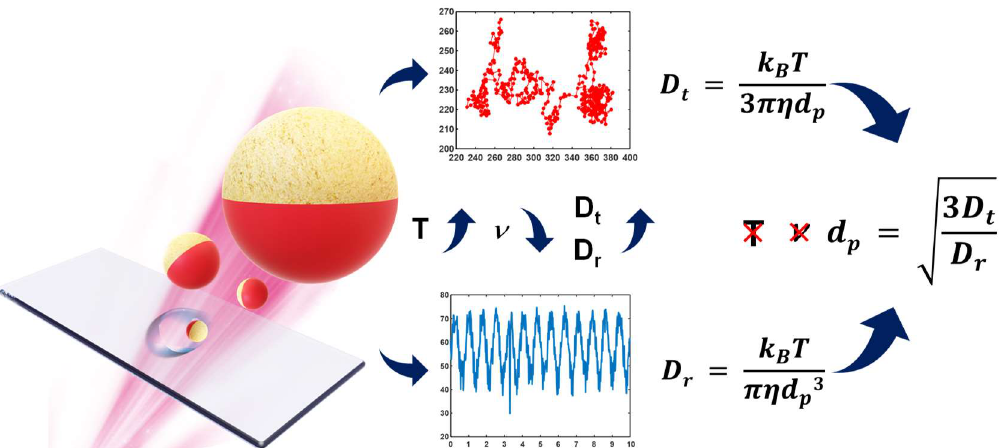
Figure 1. Schematic of self−viscosity and temperature−compensated technique. The translational diffusivity was determined by particle trajectory, whereas the rotational diffusivity was defined by the blinking signal of the Janus particles. The particle size could be estimated from the ratio of the translational diffusivity to the rotational diffusivity. An immunoassay was applied to increase the particle size and verify the proposed technique, because the translational diffusivity and the rotational diffusivity are size-dependent.